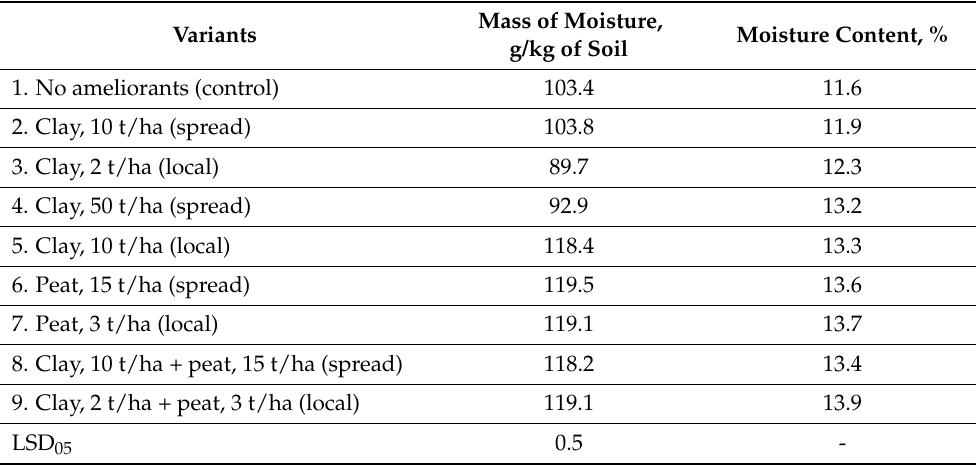
Table 4. Effects of structural land reclamation on the field moisture capacity of sod-podzolic cohesive sandy gleyed